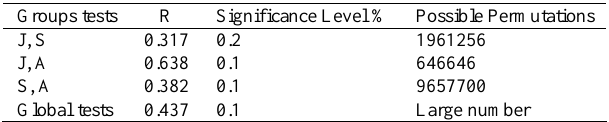
Table 4. One-way ANOSIM testes using ontogenetic factor for independent groups: comparing the total length (Lt)